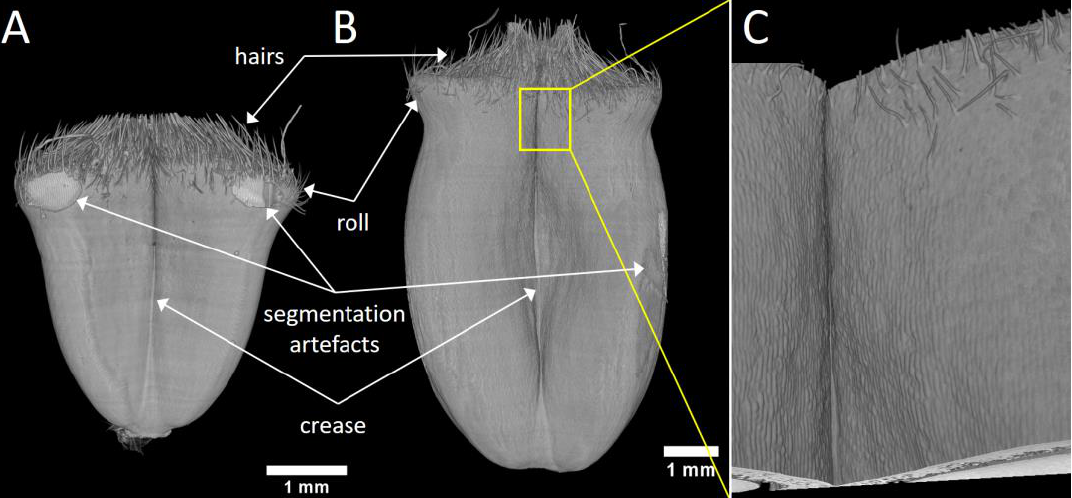
Figure 3. 3D representations of wheat grain after image segmentation. The binary mask obtained after segmentation was combined with the grayscale image and rendered with the 3D Viewer plugin of the ImageJ software. ( A ) Sample grain at 100 °DAA, front view. ( B ) Sample grain at 200 °DAA, front view. ( C ) Zoom on the epidermis of the grain at 200 °DAA, on the region depicted by the white frame in ( B ).